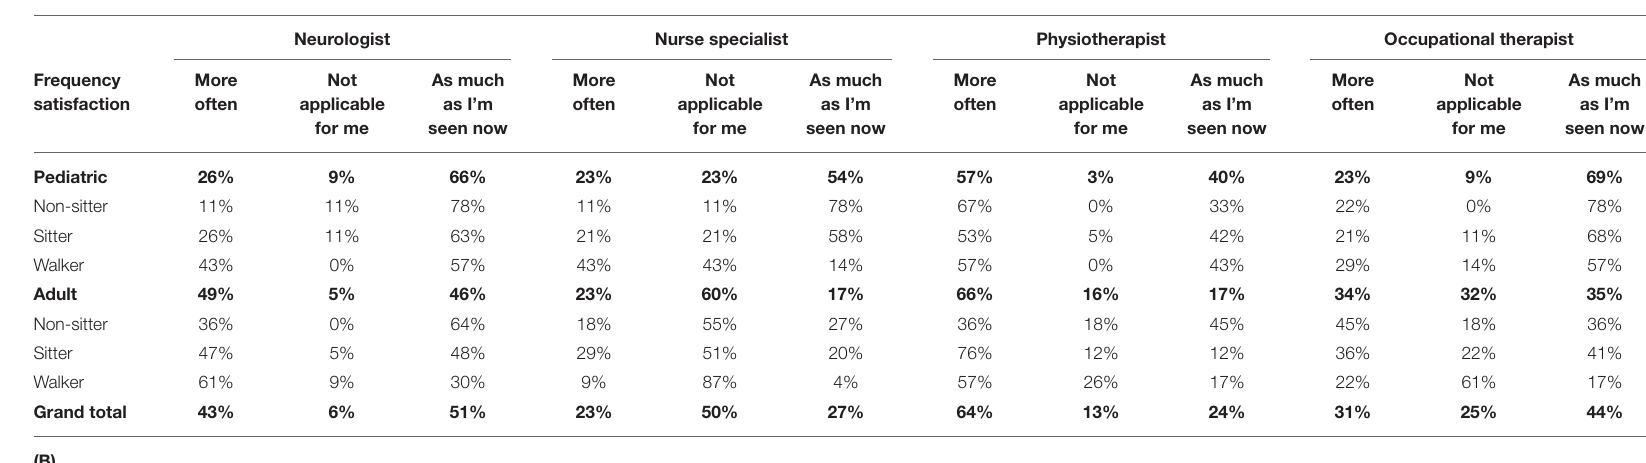
TABLE 5 | Reported frequency of access satisfaction by age and functional